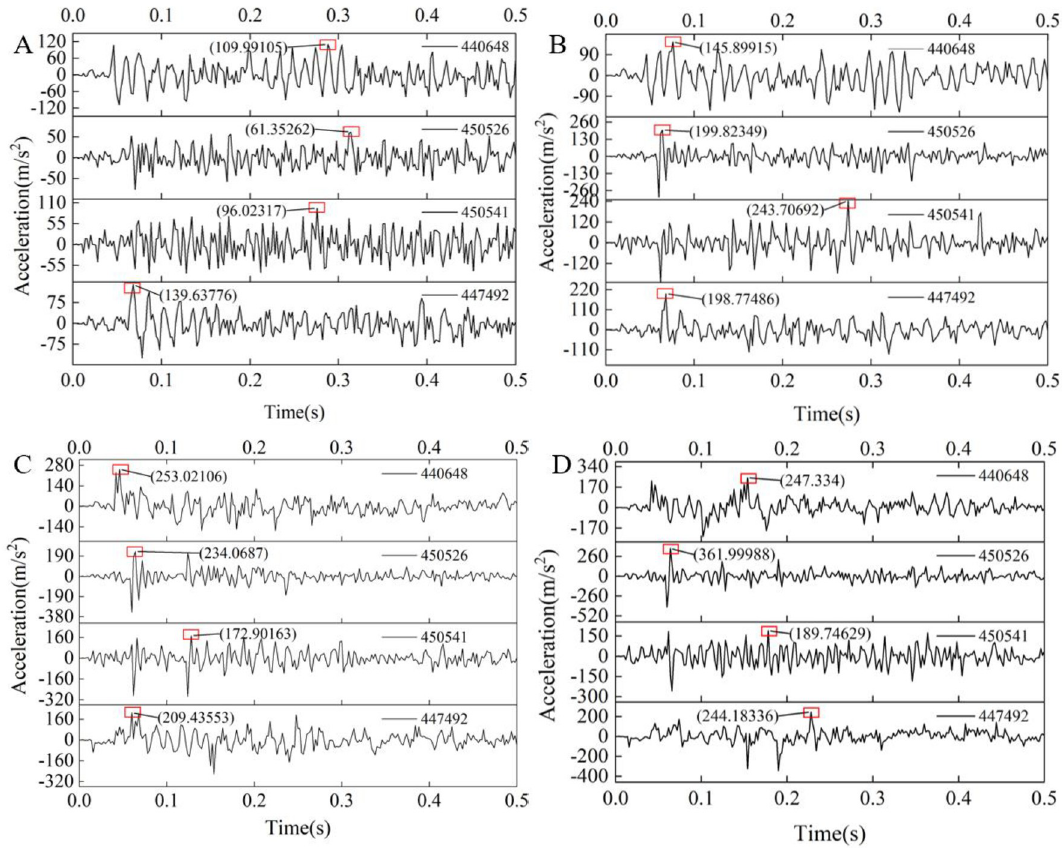
Fig 12. The acceleration signals of four nodes with different gangue content. (A)The gangue content of 0%. (B) The gangue content of 25%. (C) The gangue content of 50%. (D) The gangue content of 75%.